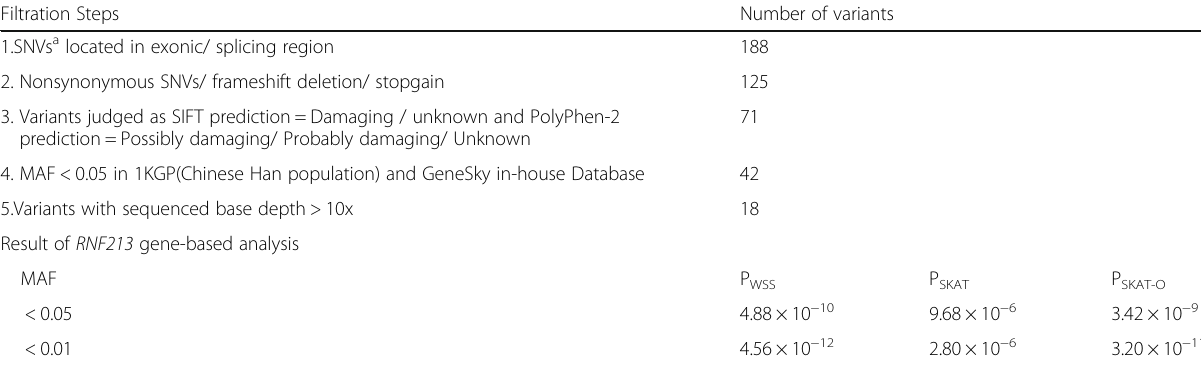
Table 2 Variant Filtration Steps of sequencing and results of gene-based analysis Filtration Steps